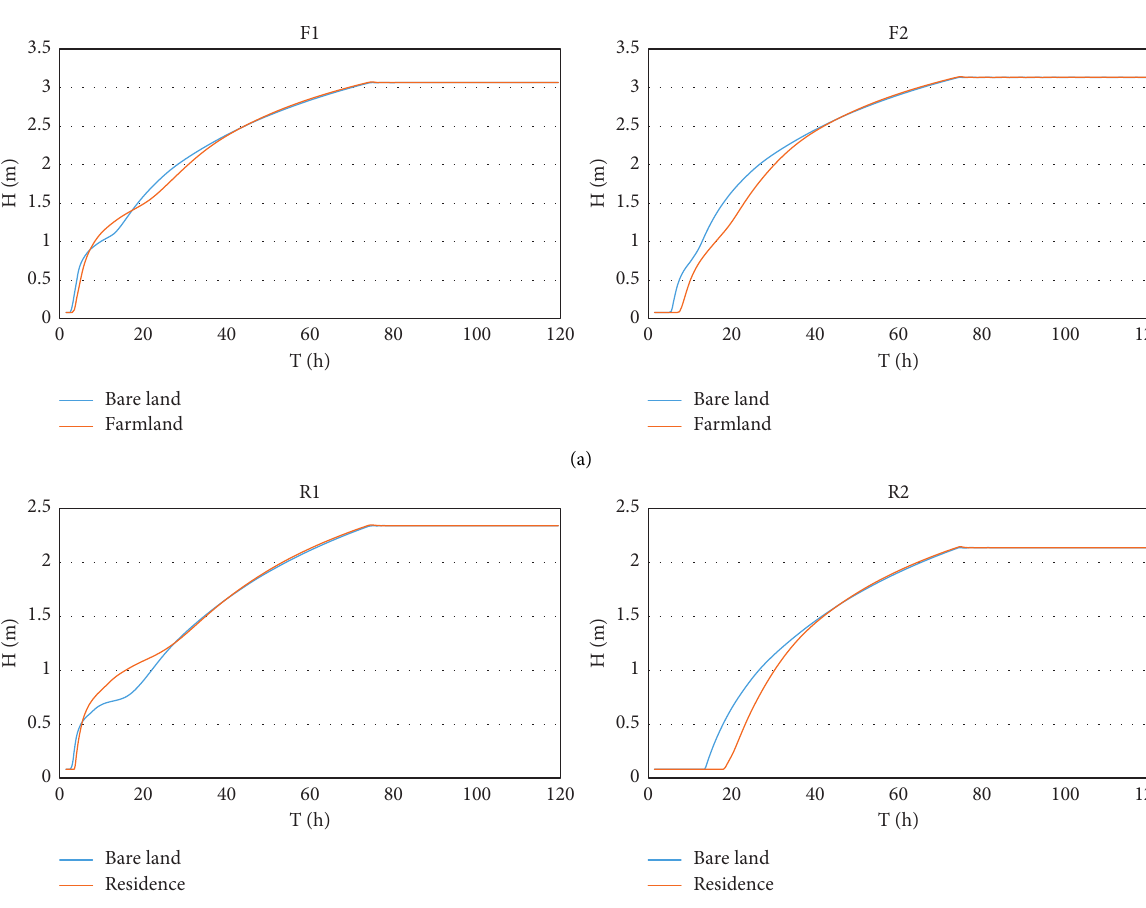
Figure 10: Land use/cover map using satellite